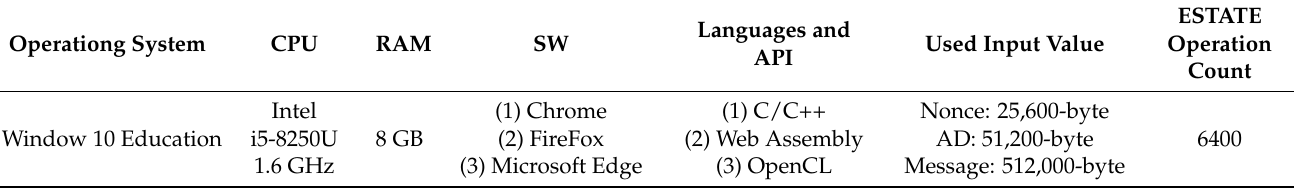
Table 7. Performance measurement